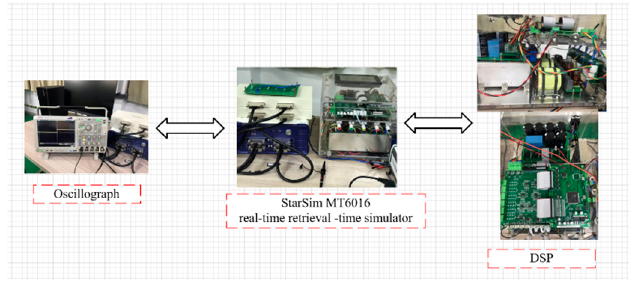
Figure 13. Structure diagram of hardware in the loop real-time simulator.